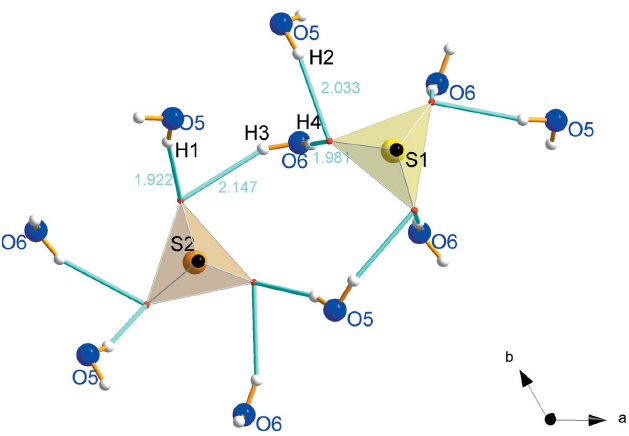
Figure 11 Hydrogen bonds from water molecules to the S1 and S2 sulfate groups.